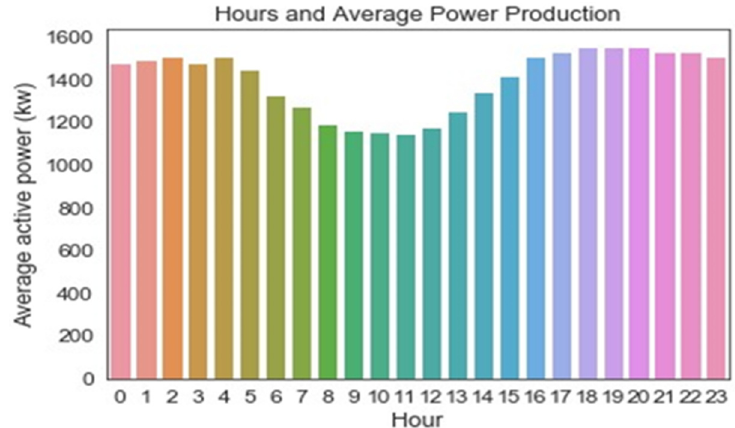
Figure 4. Hourly average power production throughout a day (kW).